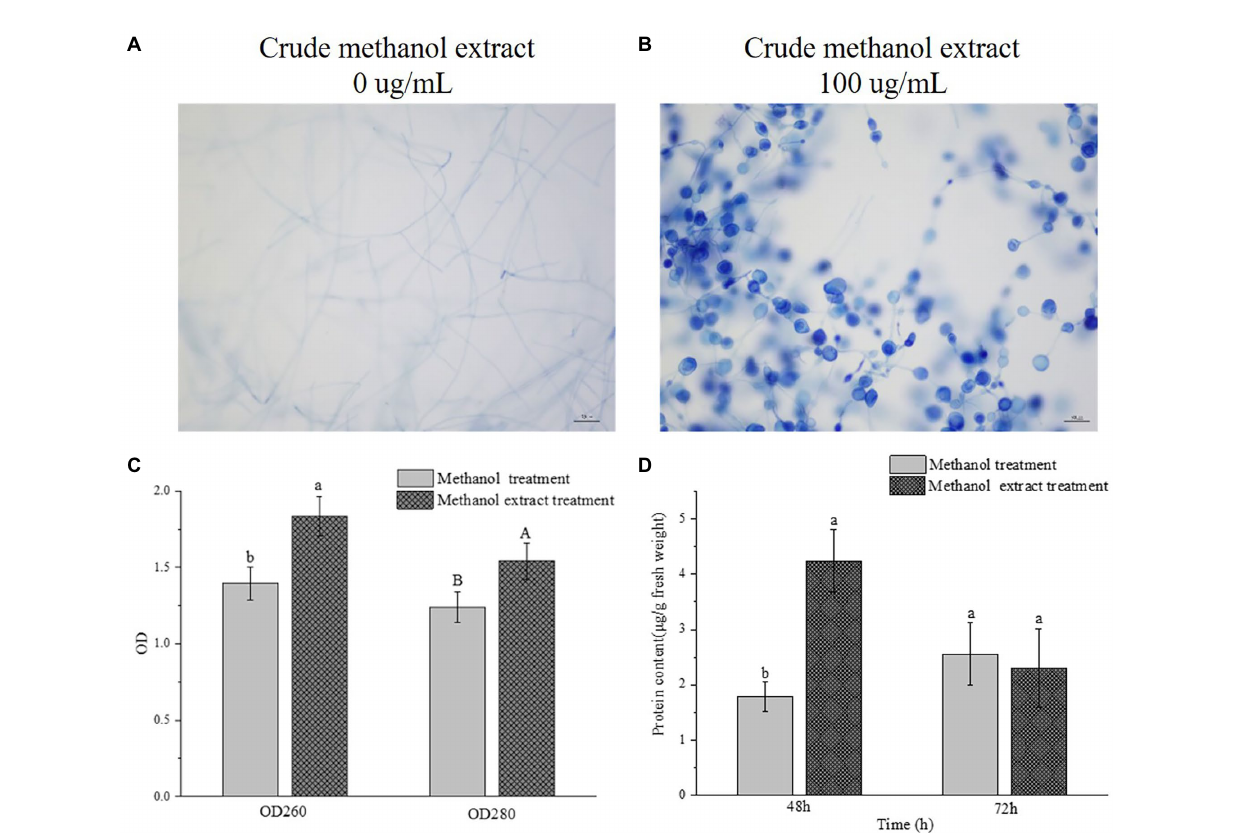
FIGURE 5 Effects of crude methanol extract on the membrane permeability and protein content of F. graminearum hyphal cells. (A,B) 40× optical micrograph of Trypan blue stained mycelia treated with crude methanol extract for 48 h. (C) Leakage levels of nucleic acid (OD 260 ) and proteins (OD 280 ) from F. graminearum suspensions, with or without treatment with crude methanol extract (100 μ g/ml). (D) In vivo protein content of F. graminearum . Different letters indicate significant differences between the lines ( p <